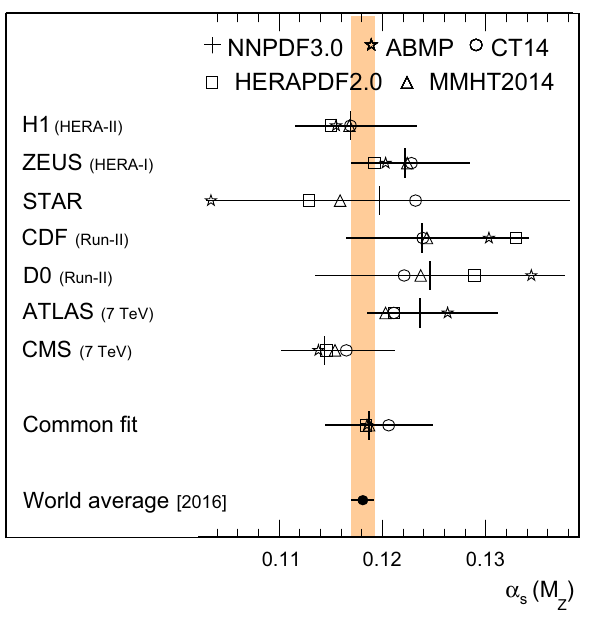
Fig. 6 Comparison of results for α s ( M Z ) obtained with the alter- native PDF sets ABMP16, CT14, HERAPDF2.0, and MMHT2014 (left), and (right) with the NNPDF3.0 variants NNPDF3.0_hera (NH), NNPDF3.0_atlas (NA), NNPDF3.0_cms (NC), NNPDF3.0_nolhc